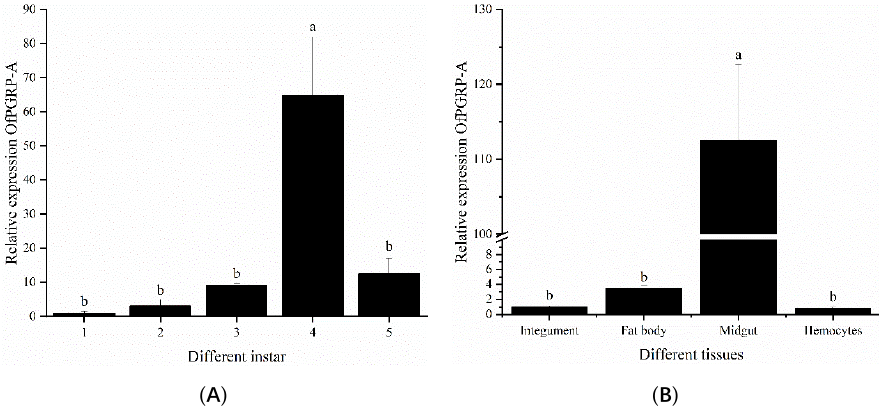
Figure 3. Relative expression levels of OfPGRP-A in different developmental stages ( A ) and adult tissues ( B ) of Ostrinia furnacalis . The small letters represent a signifificant difference (one-way ANOVA, followed by Tukey’s test as post hoc, p < 0.05).